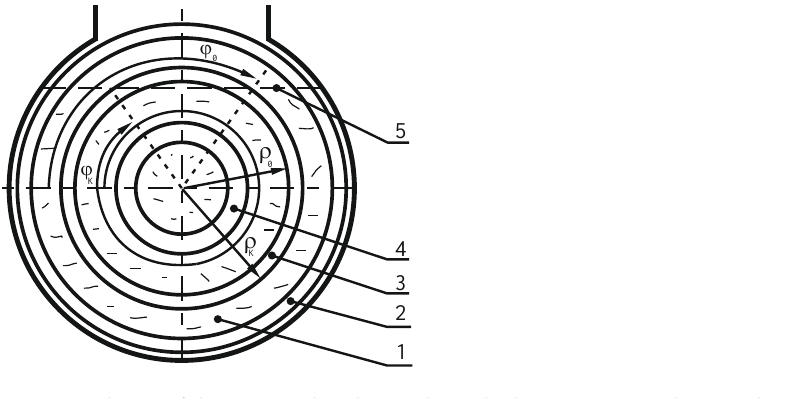
Figure 4. Scheme of the mixing chamber with marked interaction angles φ and central screw radii ρ ; 1—mixing chamber; 2—external screw; 3—middle screw; 4—internal screw; 5—upper material layer of the mixing chamber.